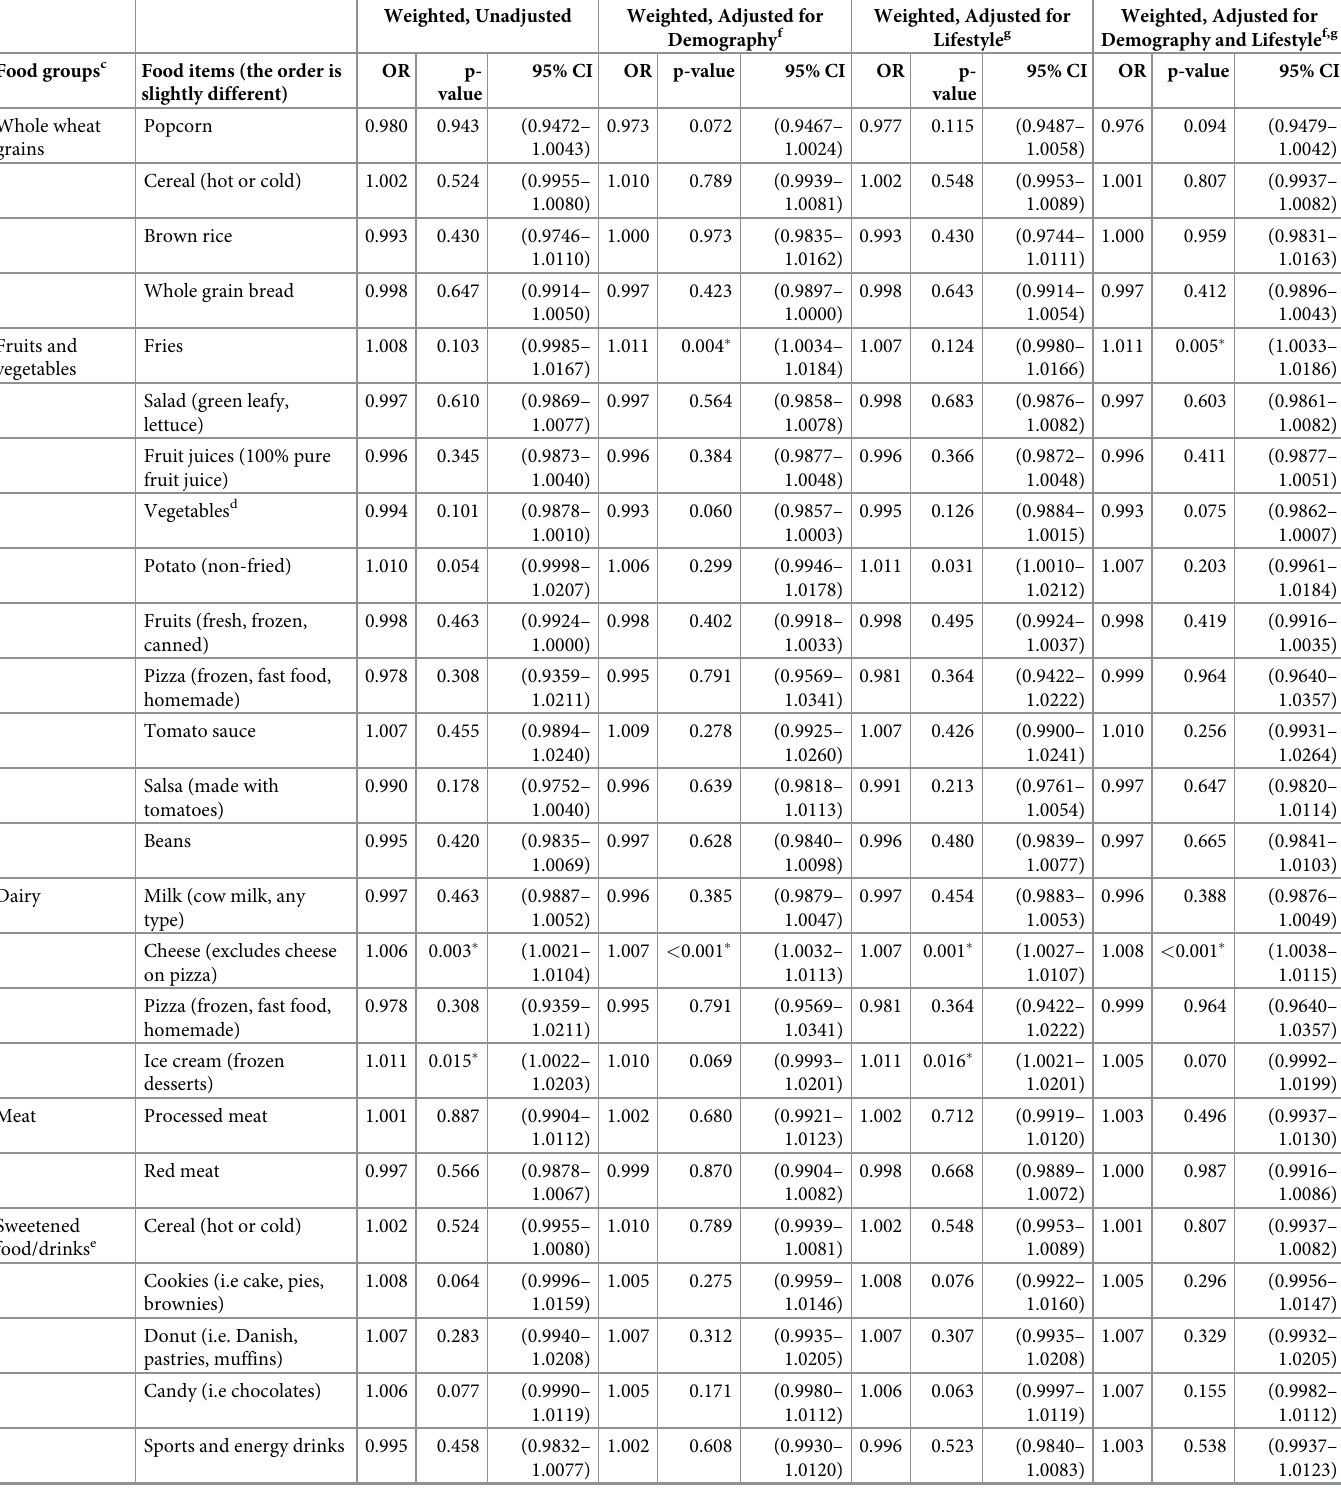
Table 2. Association (OR h ) of food consumption frequency and IBD in estimated US population, NHIS 2015 a,b .